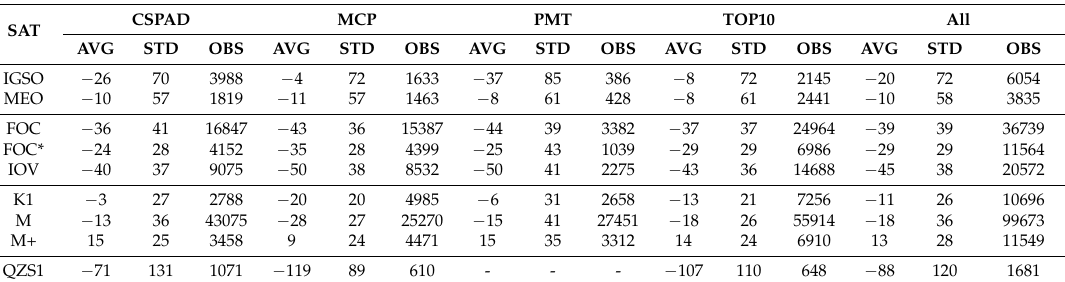
Table 3. SLR residual offset (AVG) and standard deviations (STD) for the period 1 January 2016–31 July 2017. Results divided between different sets of laser stations. All values in mm. Included groups of satellites (SAT): BeiDou IGSO and MEO, Galileo FOC, FOC* launched on the extended highly eccentric orbit, IOV, GLONASS K1, M, M+ and QZSS QZS-1. CSPAD SAT